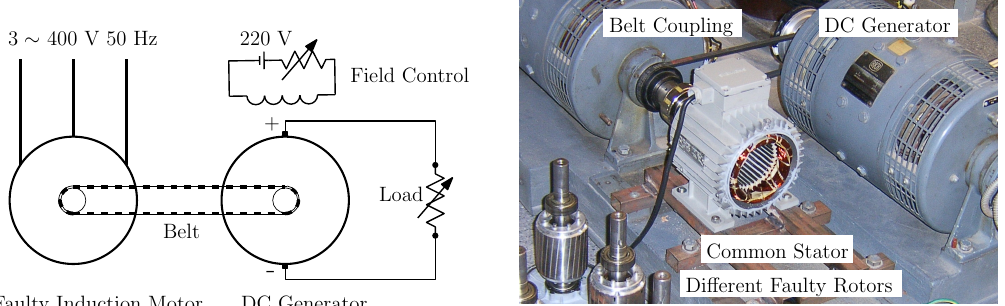
Figure 10. Schema of the loading of the experimental machine ( left ) and experimental setup ( right ). The induction motor under test (Appendix A) is connected to a DC generator via a belt coupling. The DC machine feeds a resistive load. Both the resistive load and the field excitation can be controlled so that the induction machine works at rated